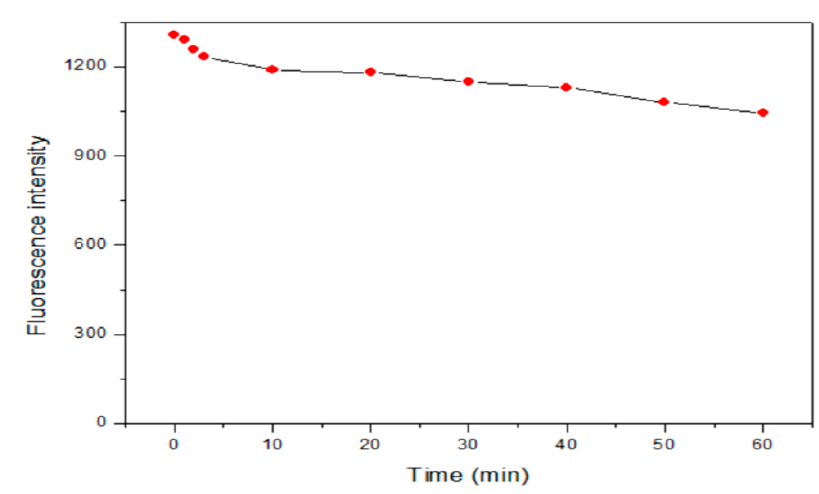
Figure 4. Photostability study of the BSA-Cu NCs.